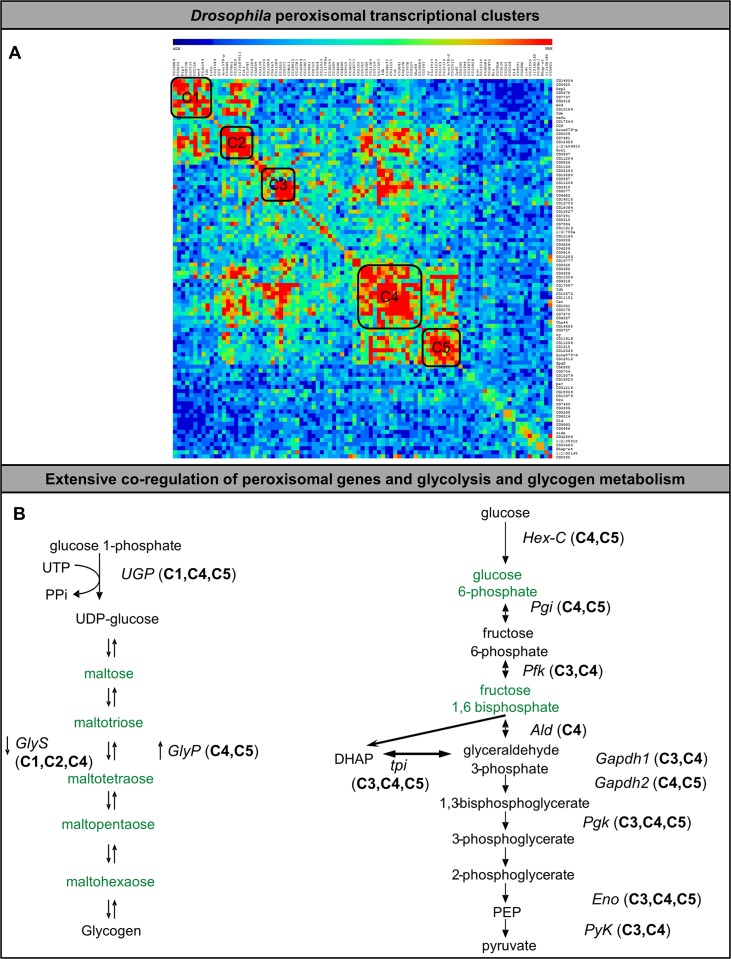
Drosophila peroxisomal gene networks.(A) Drosophila peroxisomal genes were manually selected and assembled into a correlation matrix using the g:Profiler tool. These Drosophila peroxisomal genes are clustered in 5 co-regulated gene clusters that were subsequently used to identify the top 1000 genes for each cluster that has a similar expression pattern from Drosophila gene expression data-sets. (B) Co-regulated genes within the top 1000 genes in each cluster include multiple pathways in carbohydrate metabolism including glycogen metaboliwsm and glycolysis The metabolomics results from Fig 6 with green indicating a consistent decrease in metabolite levels in the pex mutants, are overlaid with the genes responsible for the relevant steps in metabolism and their representation within the gene cluster (C1 = Cluster 1, C2 = Cluster 2 etc.).